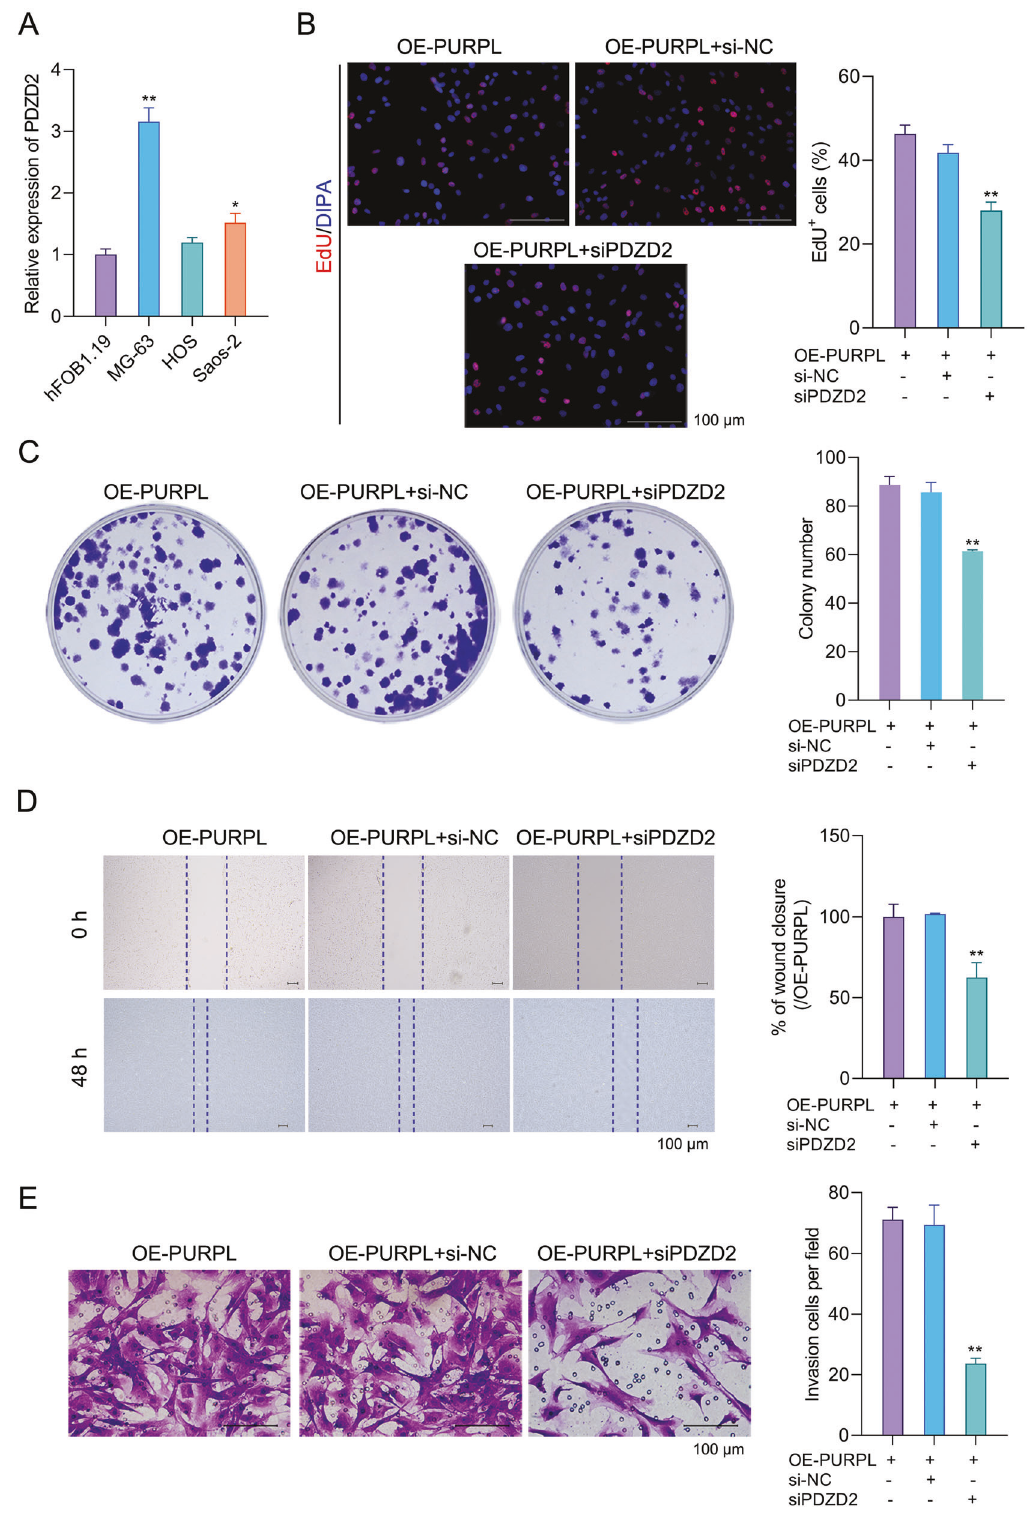
Fig. 5 Silence of PDZD2 weakened the in fl uence of PURPL overexpression on MG-63 cell proliferation, migration, and invasion. A qPCR was used to test the PDZD2 expression in hFOB1.19, MG-63, HOS, and Saos-2 cells. MG-63 cells were subjected to OE-PURPL and/or siPDZD2 transfection. Proliferation ( B , C ), migration ( D ), and invasion ( E ) of MG-63 cells were detected via EdU incorporation assay, colony formation assay, scratch wound assay, and transwell assay, respectively. *P < 0.05, **P < 0.01 vs. hFOB1.19 or OE-PURPL + si-NC